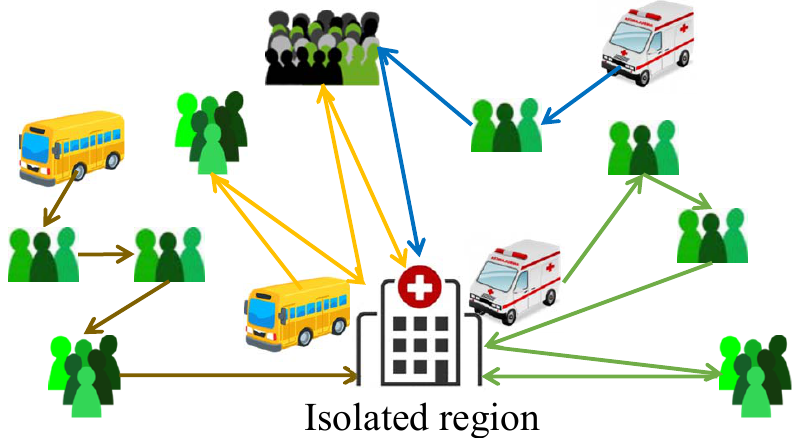
Figure 1. An illustration of the vehicle routing problem for transferring high-risk individuals in